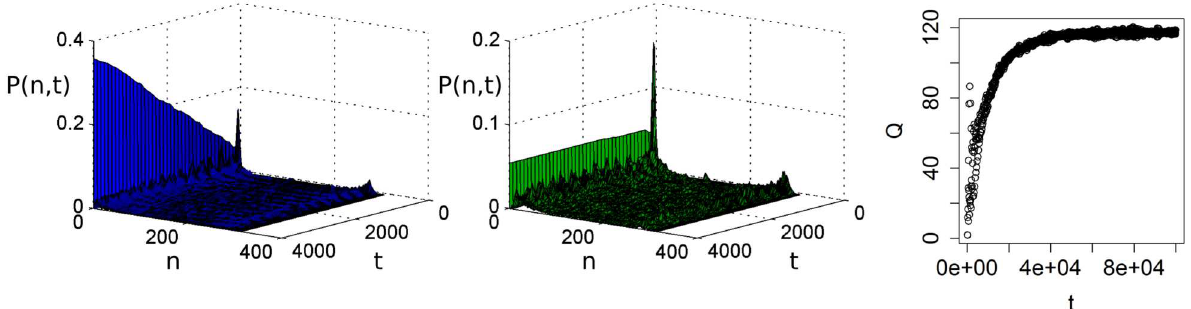
Fig 9. Time-dependent histograms at E h = 0.07. (a): Histogram of the ABM without adaptation.(b): Histogram of the ABM with adaptation. (c): The value of Q as a function of time. The value of Q increasesas without adaptationan increasing number of runs goes to